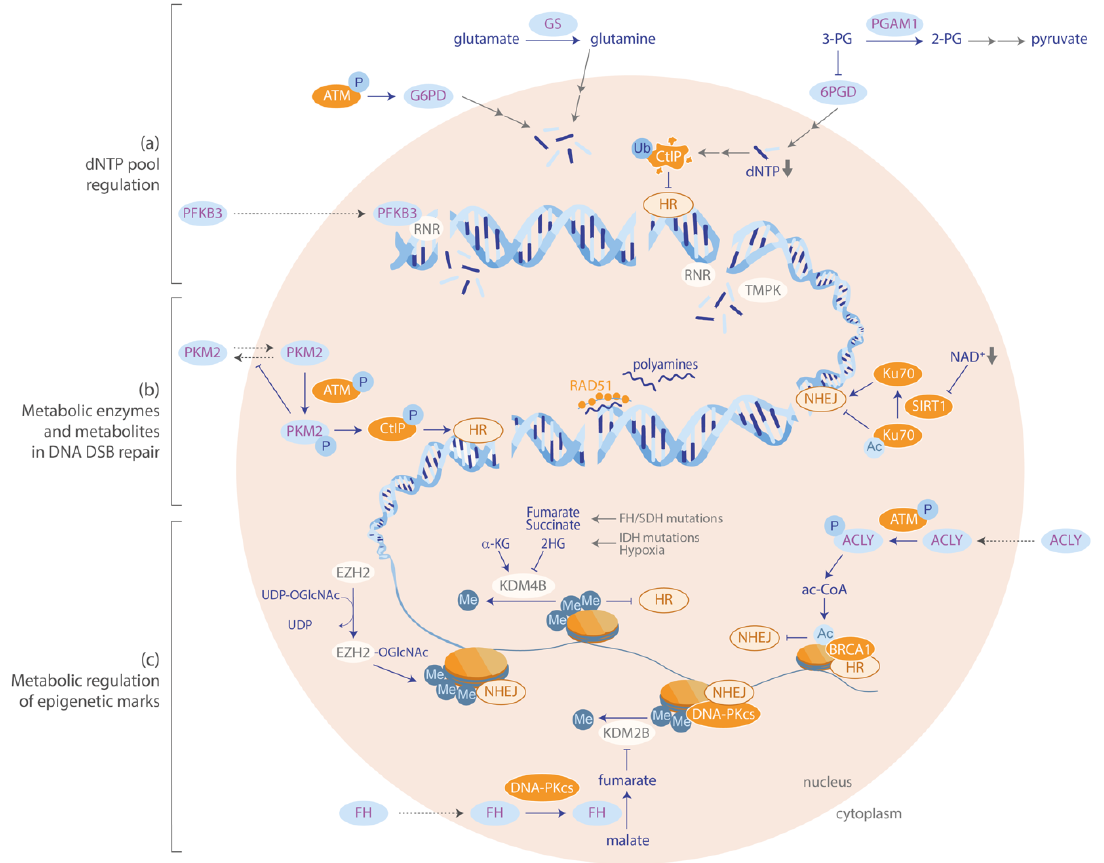
Figure 2. Metabolism and the repair of DNA double-strand breaks. Crosstalk between metabolism and DNA repair can be classified into three categories: ( a ) dNTP-pool regulation is critical for DNA repair, ( b ) metabolic enzymes and metabolites are directly involved in DSB repair, and ( c ) metabolic regulation of epigenetic marks influences DNA repair.